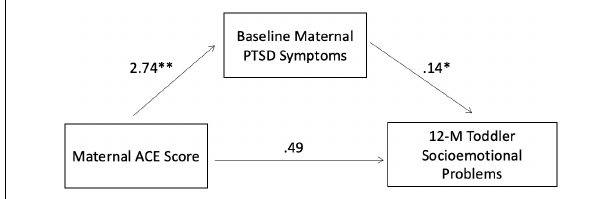
FIGURE 1 | Regression analysis summary for parent variables predicting toddlers’ socioemotional problems. R 2 = 0.25 ( N = 58, p = 0.0004). ∗ p = 0.0041; ∗∗ p =